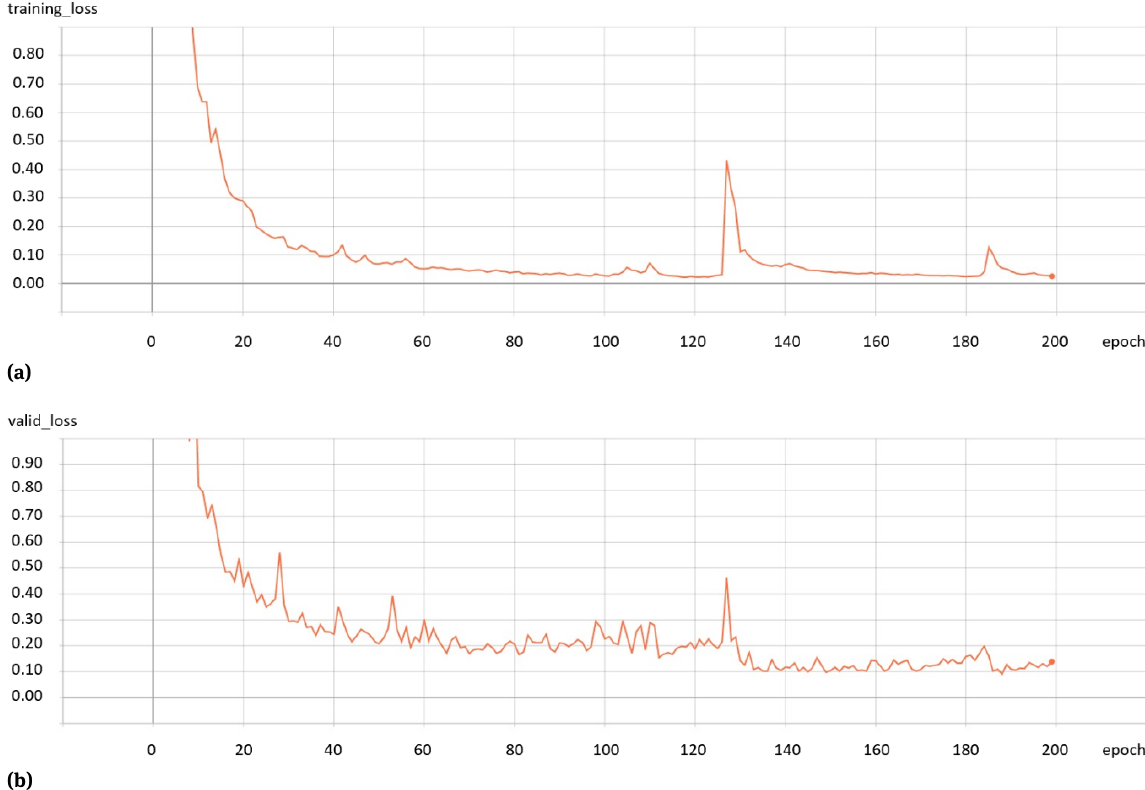
Figure 5: Error dependence L during the learning process a) for the data_train set, b) for the data_valid